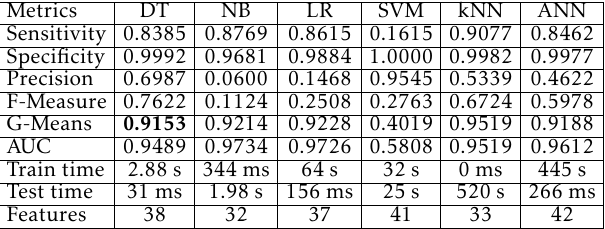
Table 3. Results of using IG-BFE algorithm on WORMS. Metrics